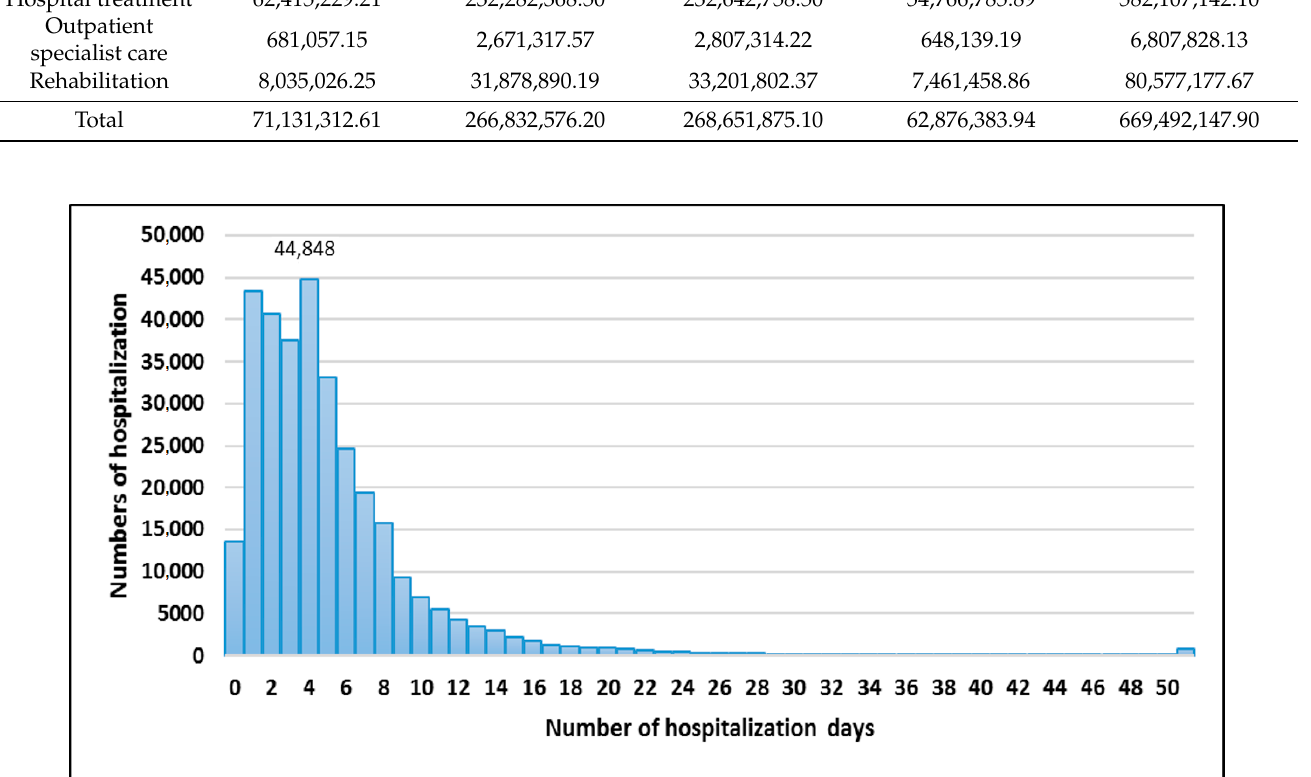
Figure 2. Length of hospitalisation (in days) of hospital readmissions reported for patients not covered by CCMI.